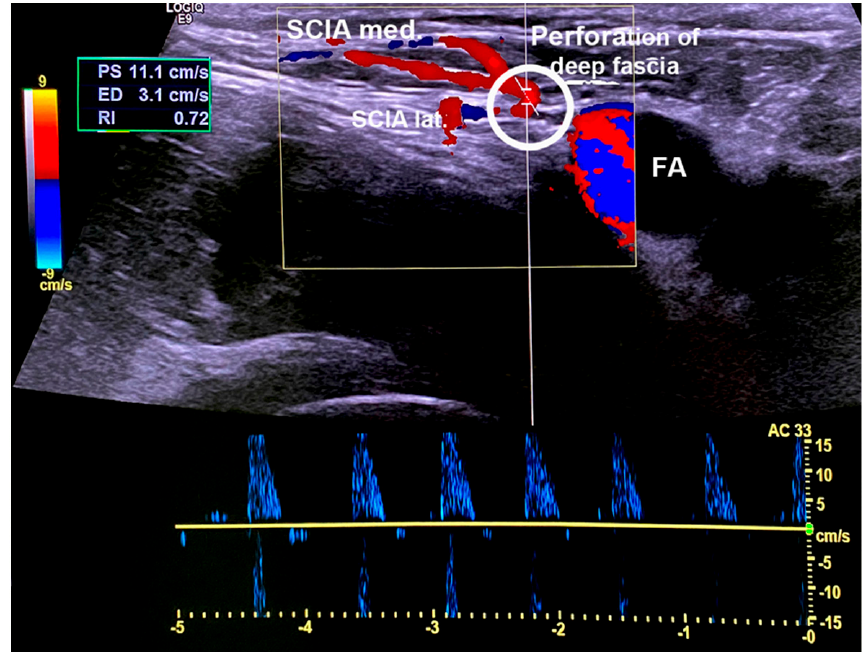
Figure 5. Screen shot in Pulse Wave (PW) mode while measuring pulse systolic velocity (PS), end diastolic velocity (ED), and the resistance index (RI) at the emergence point of the medial superficial branch perforating the deep fascia (SCIA med.). In the same plane, the lateral deep branch of the SCIA (SCIA lat.) can be visualized. FA = femoral artery.